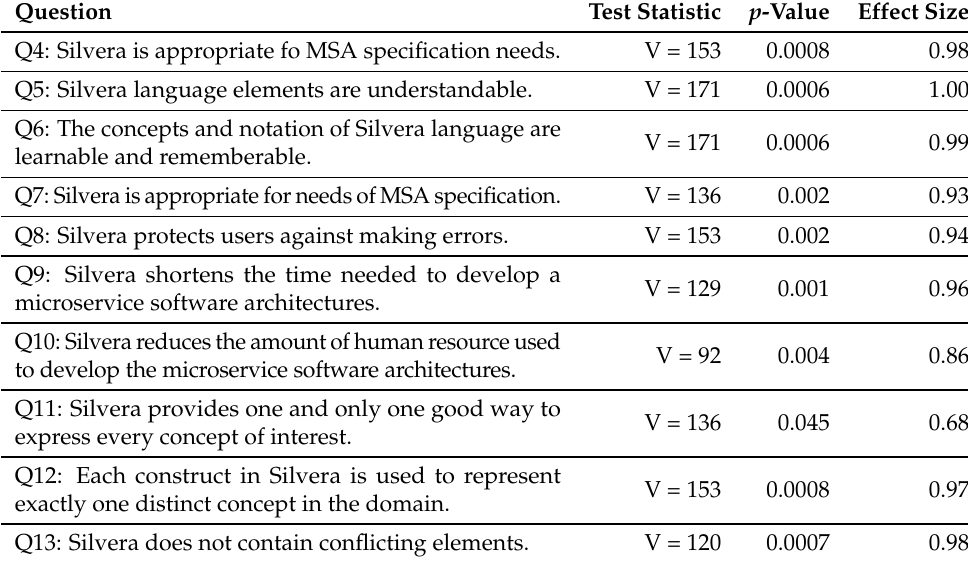
Table 18. The corresponding test statistic, p -value and effect size for every question from groups Functional suitability , Usability , Reliability , Productivity , Extendability and Expressiveness